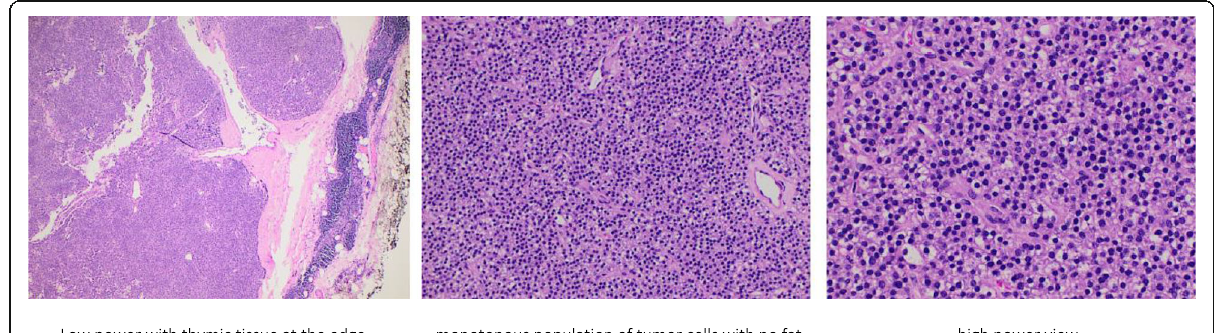
Fig. 6 Histopathological findings: Sections show a hypercellular tumor composed mostly of round to polygonal cells with round monotonous/ isometric nuclei and moderate eosinophilic granular cytoplasm. The cells are arranged in solid sheets and occasionally form small nests and pseudo-follicles. No intervening adipose tissue is seen. A remnant of thymic tissue appears at one edge. The overall feature perfectly fits a parathyroid